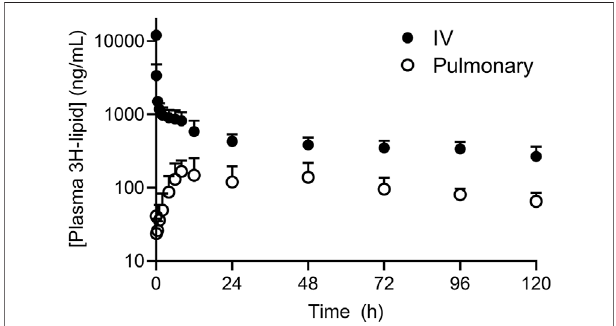
FIGURE 1 | Plasma concentration-time pro fi le of 3 H-lipid after administration of radiolabeled ( 3 H-phosphatidylcholine) liposomes to sheep via intravenous ( black circles ) or pulmonary ( open circles ) administration. Plasma concentrations were normalized to a dose of 1 mg/kg. Data represent mean ± SD ( n = 4).